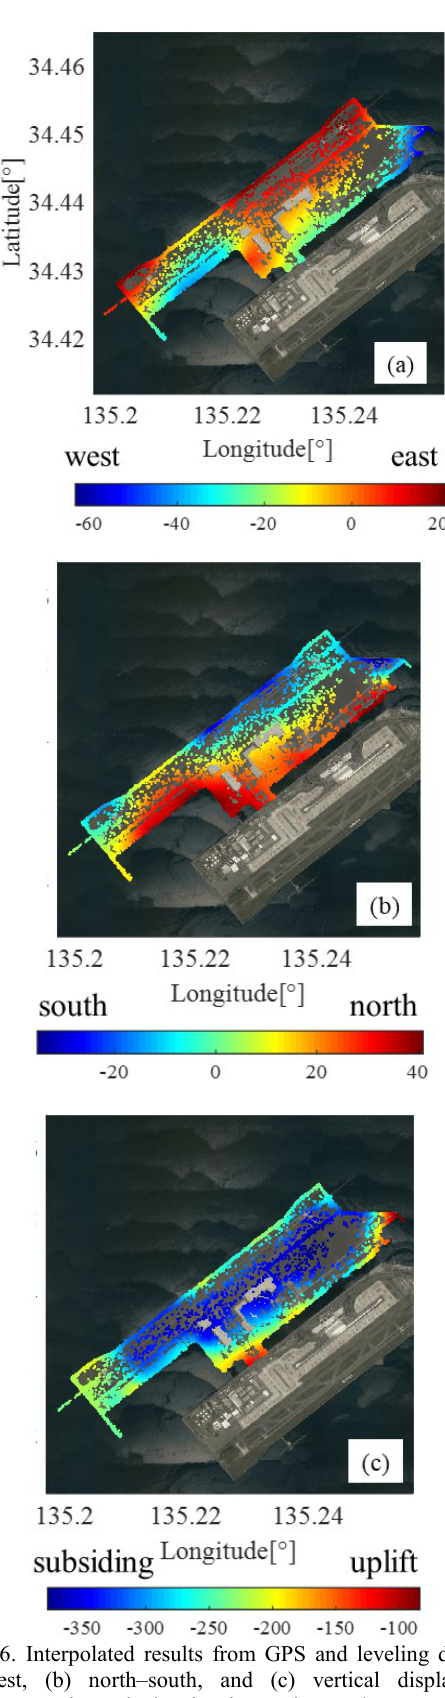
Figure 6. Interpolated results from GPS and leveling data: (a) east–west, (b) north–south, and (c) vertical displacement component. The velocity is shown in mm/year. Map data